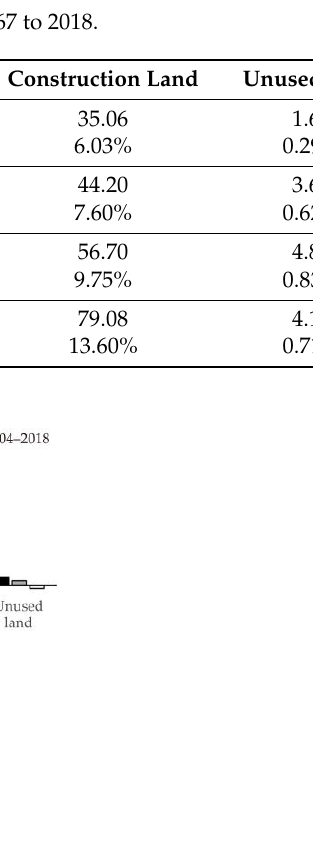
Figure 3. Land use changes from 1967 to 2018 (km 2 ).